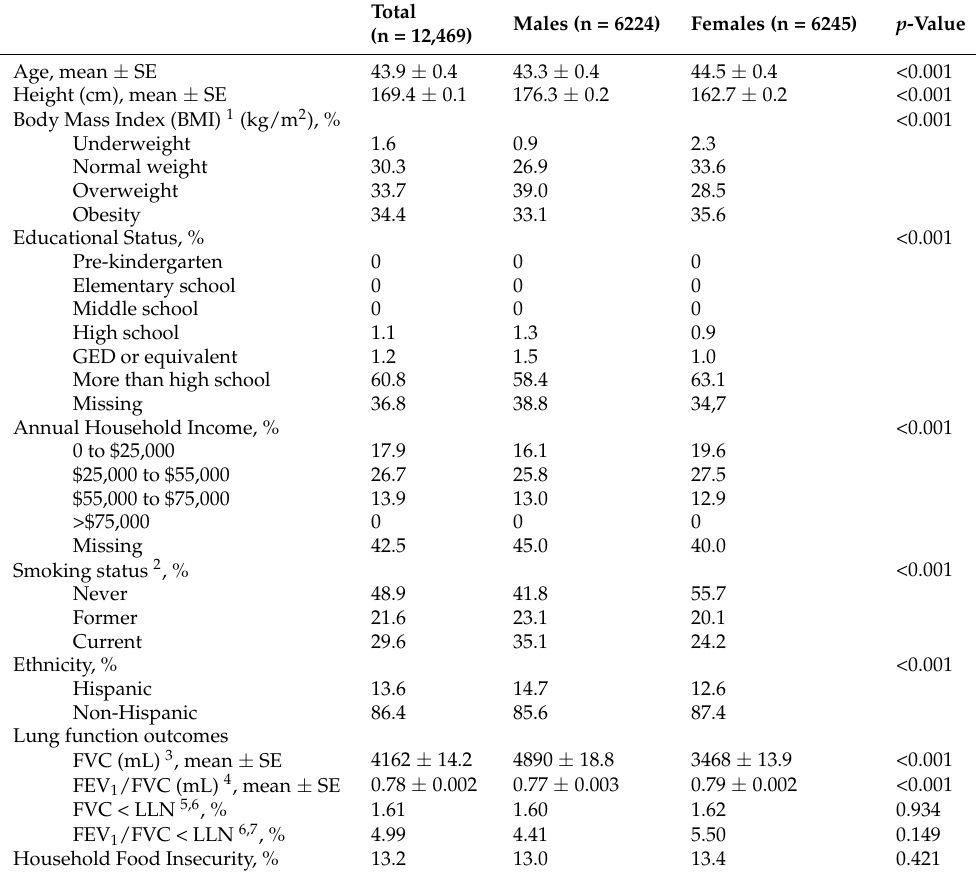
Table 1. General characteristics of